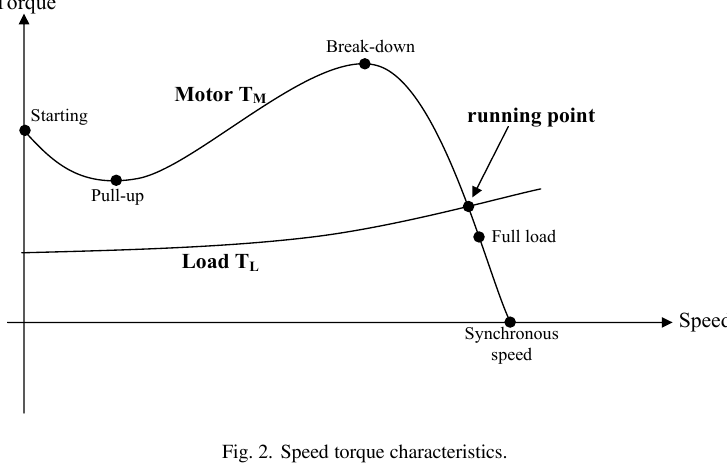
Fig. 2. Speed torque